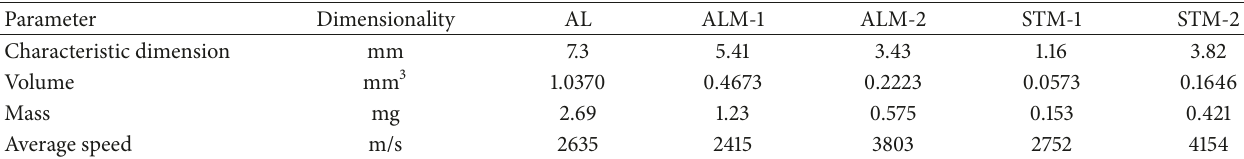
Table 3: Parameters of the central